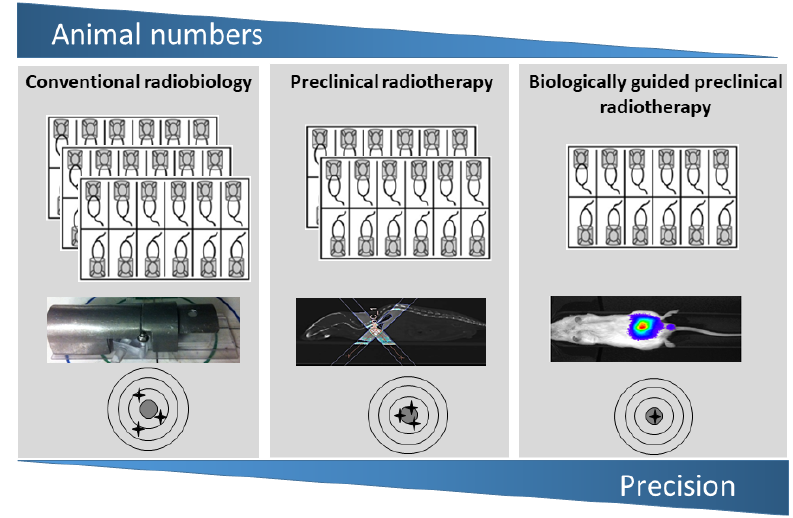
Figure 1. Schematic diagram demonstrating the evolution of conventional radiobiology to image-guided preclinical radiotherapy and molecular imaging. These changes are a major refinement of conventional techniques and have resulted in improved precision and accuracy. Overall, these advanced approaches have reduced study sizes in radiobiology studies required to obtain statistical power by reducing dose uncertainty, error and allowing longitudinal analysis.